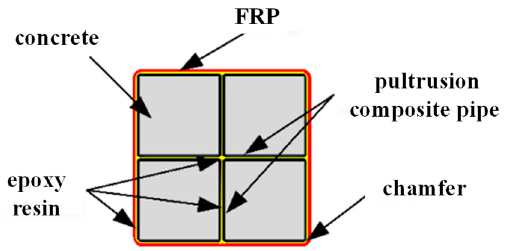
Figure 1. GFRP confined column.